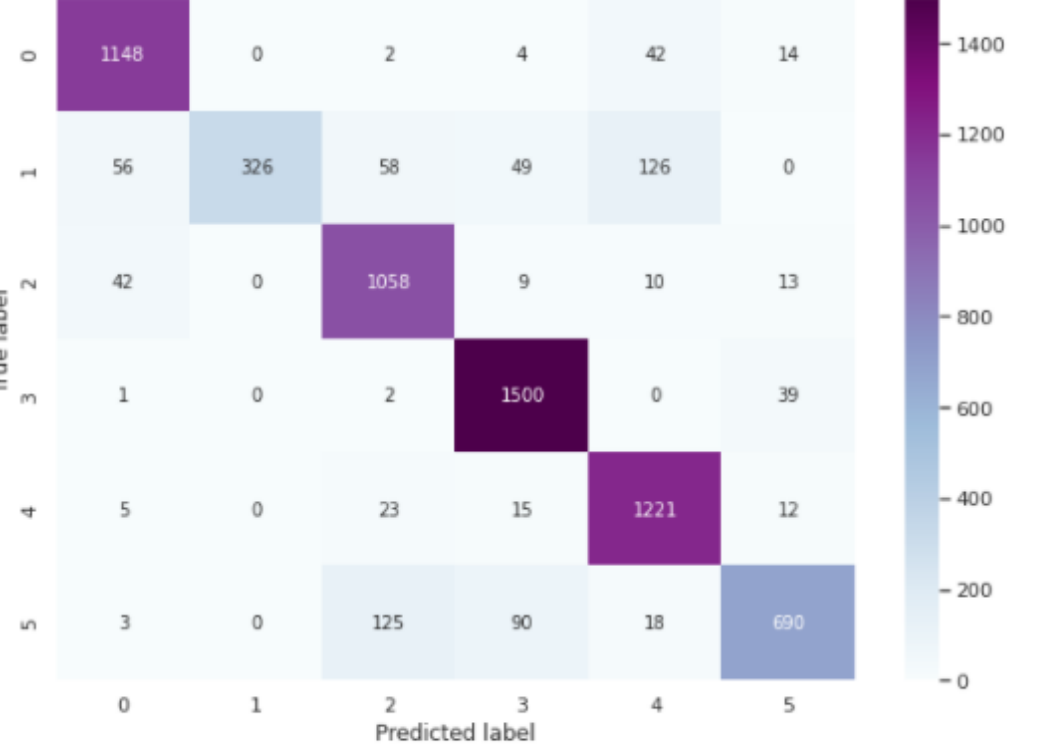
Figure 8. Confusion matrix on the combined dataset. Table 5. Precision, recall and F1-score values on the three